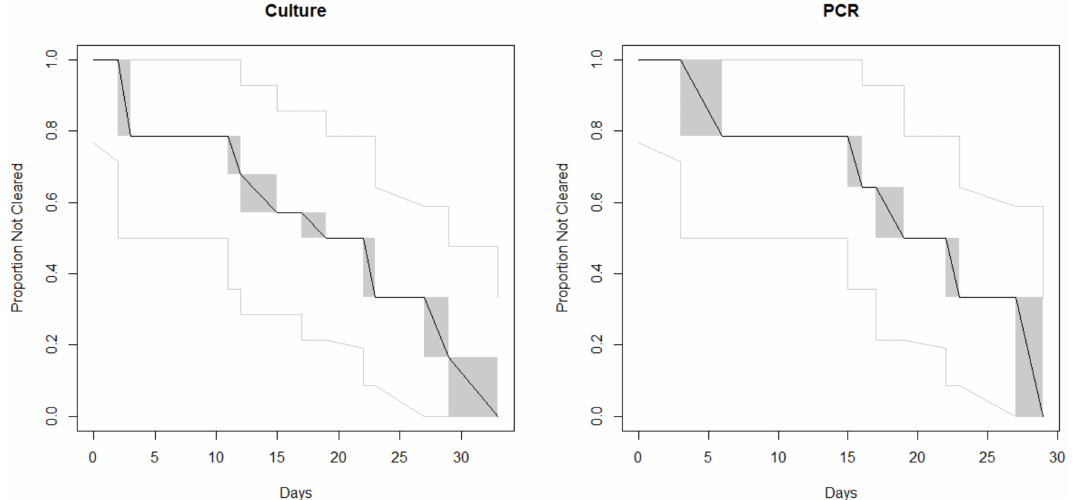
Figure 1. Clearance curves based on the Turnbull algorithm. The black line indicates the proportion of cases who had not yet cleared their STEC infection according to the given method, by day. The gray shaded regions are the Turnbull intervals during which clearance could have occurred. The light gray lines indicate the 95% confidence